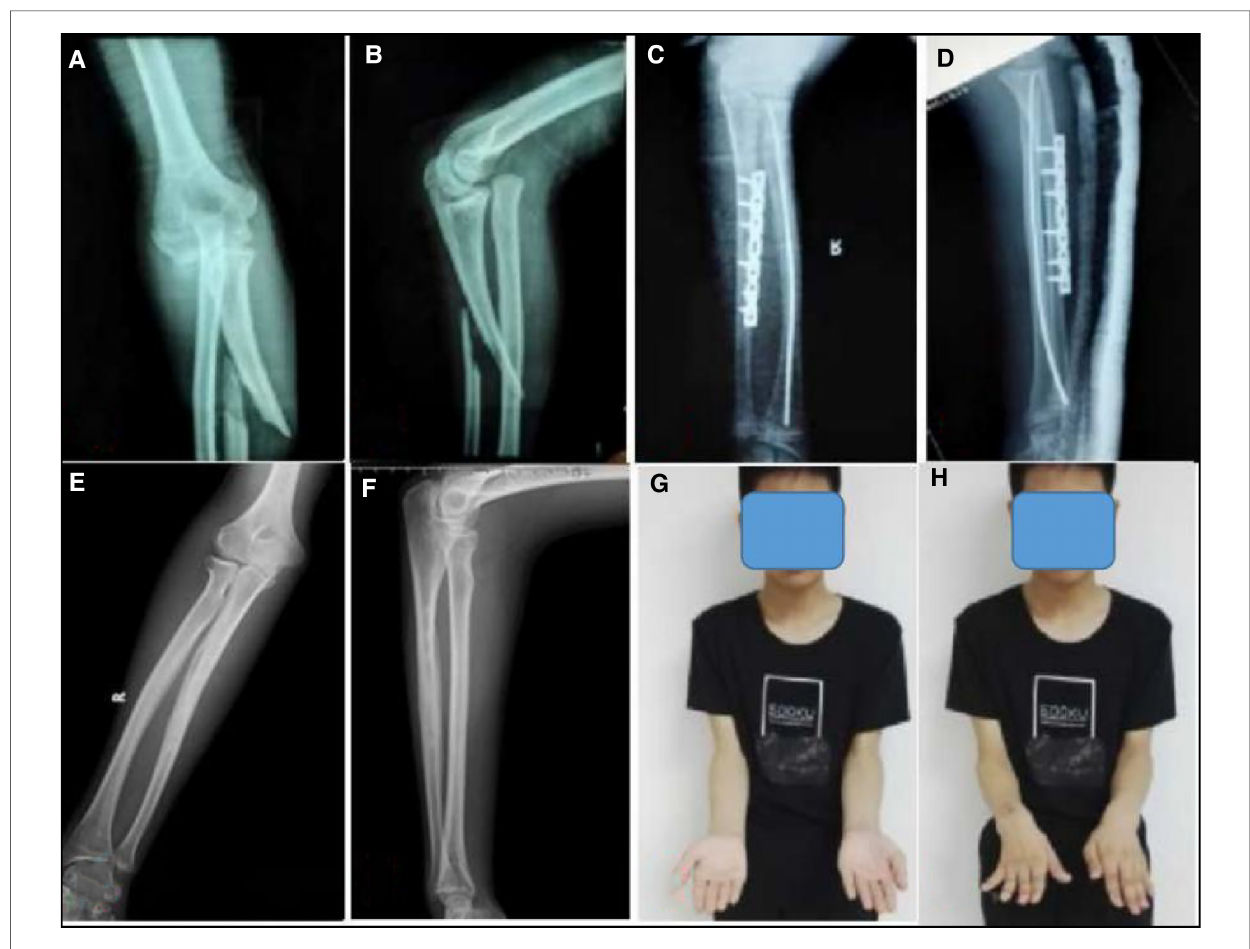
FIGURE 4 A 12-year-old boy with a head – neck separation type of Monteggia equivalent fractures (extension-valgus type) ( A,B ). OR and internal fi xation with a bone plate for an ulna fracture and CR with ESIN for a radial neck fracture ( C,D ). The last follow-up was 4.5 years after surgery, which showed normal elbow movement and an excellent MEPS ( E – H